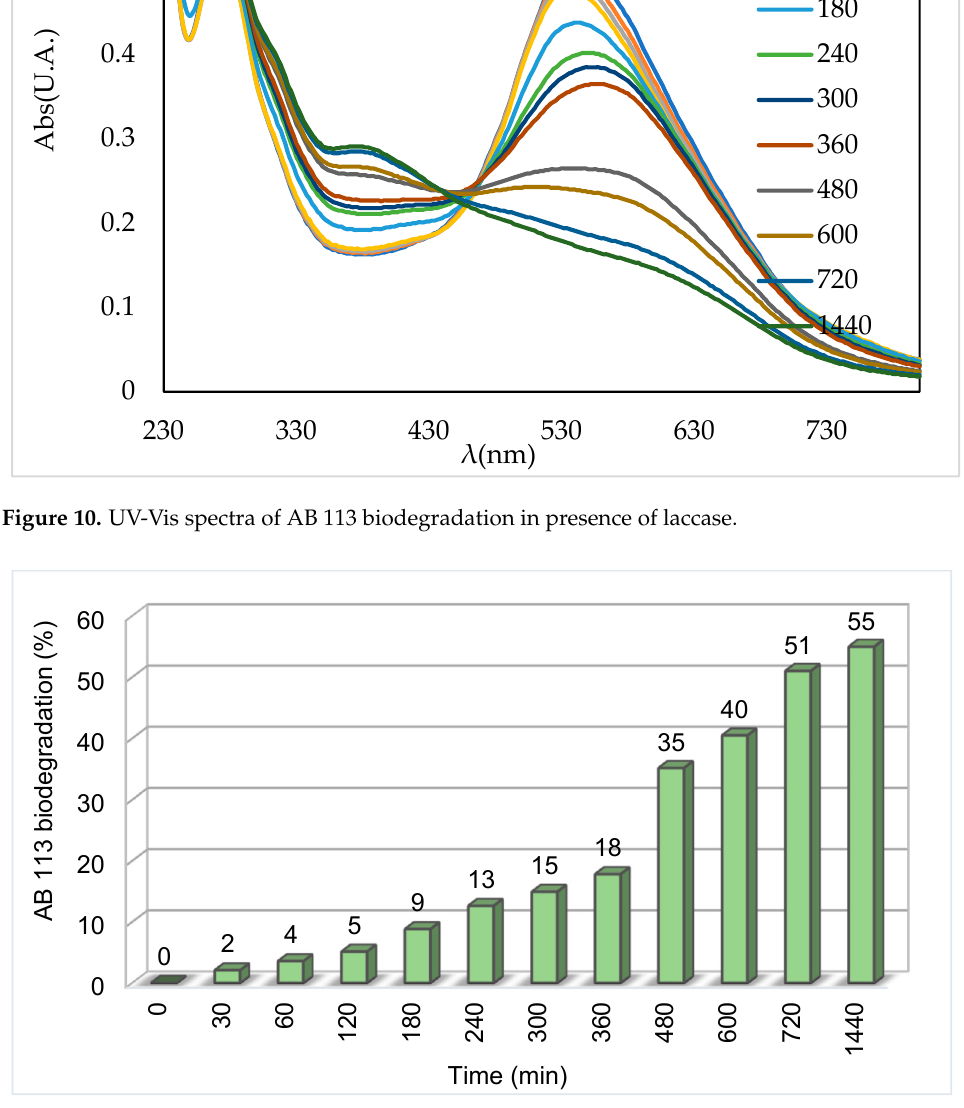
Figure 11. Time influence on AB 113 Laccase biodegradation effect.